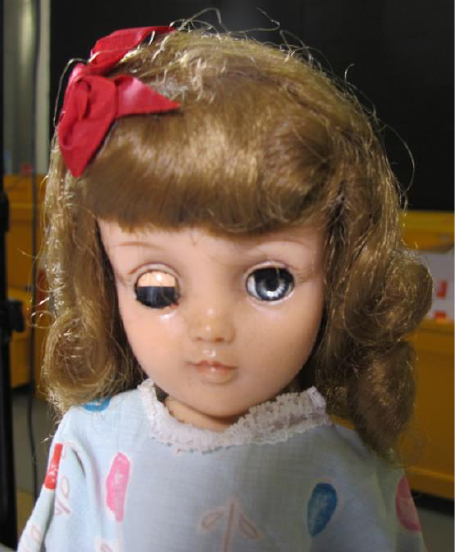
Figure 10. Failed sleep eye mechanism in CA doll A8 with a PVC head. Image ©